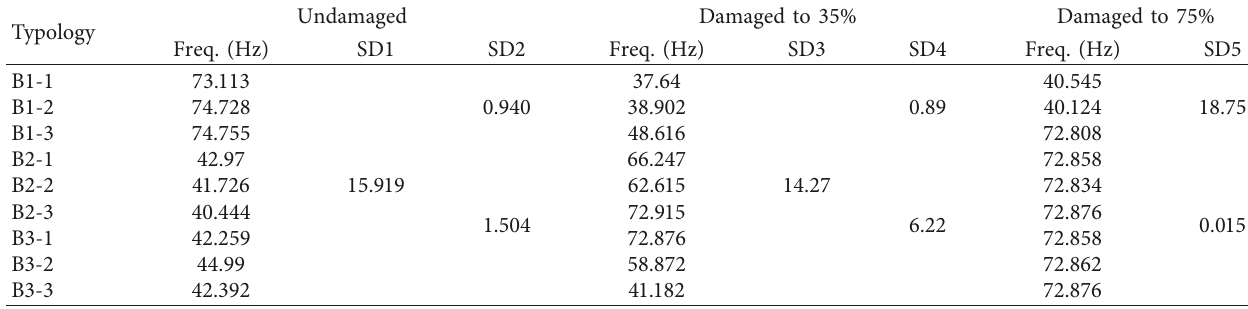
Table 7: Frequency values and standard deviation (SD) for the 2nd bending modal shape.